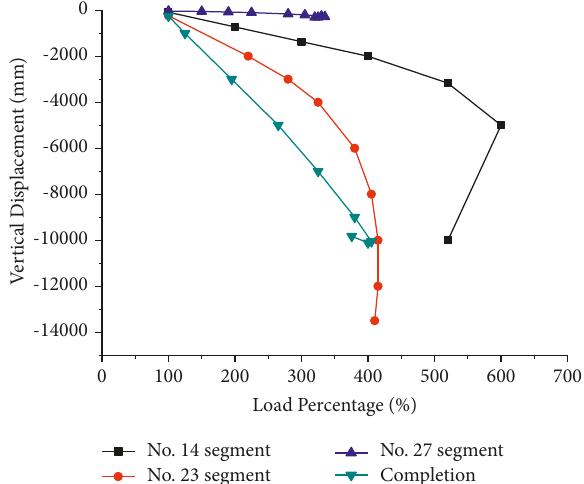
Figure 3: Vertical displacement vs. load percentage for different key construction stages.